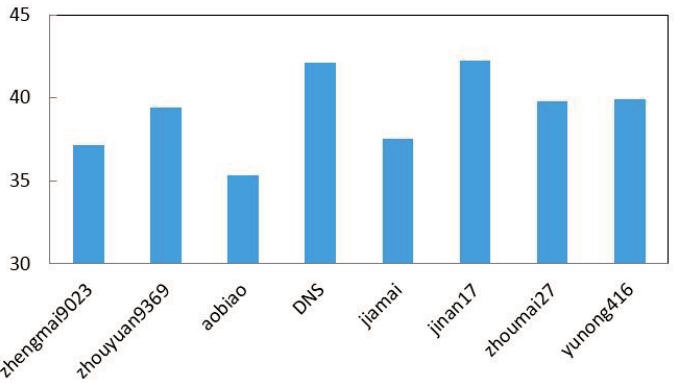
Figure 3. The average absorption coefficient of eight wheat